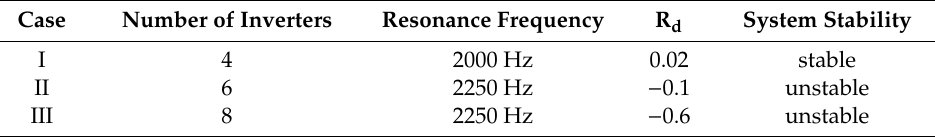
Table 4. Conclusions of the three cases.